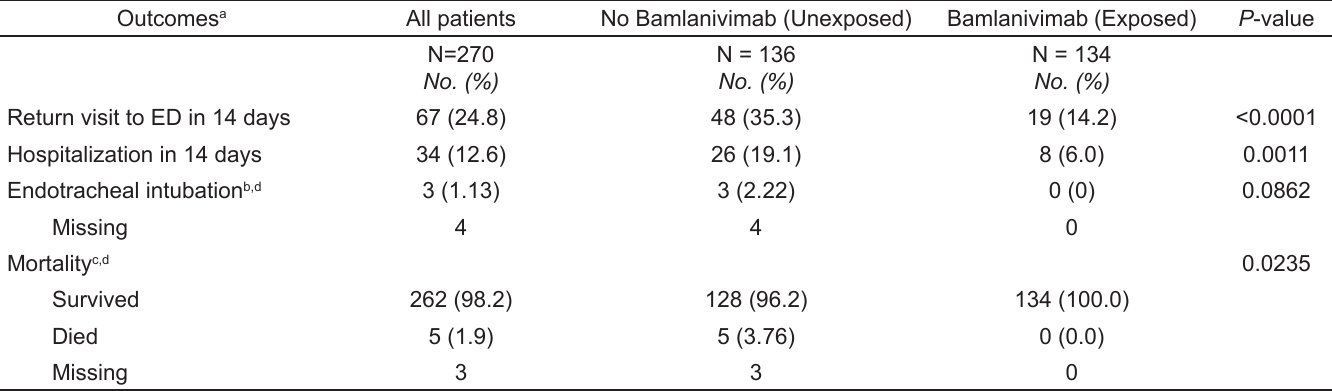
Table 2. Clinical outcomes of COVID-19 patients no bamlanivimab exposure vs bamlanivimab